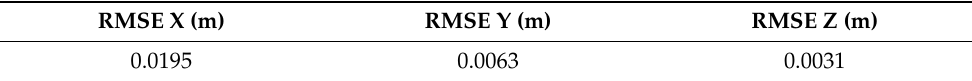
Table 3. PLS co-registering